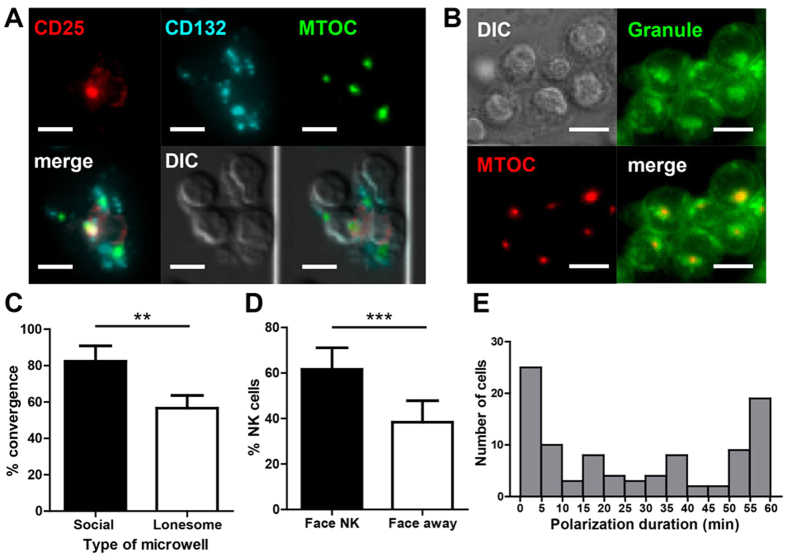
NK cells in social microwells polarized CD25, MTOC, and lytic granules toward neighboring NK cells.(A) Representative images showing the distributions of CD25, CD132, and the MTOCs of NK cells in social microwells. (B) Representative images showing the distributions of lytic granules and the MTOCs of NK cells in social microwells. (C) Quantification of lytic granule convergence to the MTOC. N = 248 (social), and N = 60 (lonesome) (D) Percentage of NK cells exhibiting lytic granules pointing toward neighboring NK cells (Face NK; black bar) or pointing away from neighboring NK cells (Face away; white bar). N = 258. (E) Distribution of lytic granule polarization durations. N = 200. (A,B) Scale bar: 10 μm. (C,D) Data are representative of three independent experiments. Error bars: standard deviation. The Mann-Whitney test was performed. **p < 0.01, ***p < 0.001.